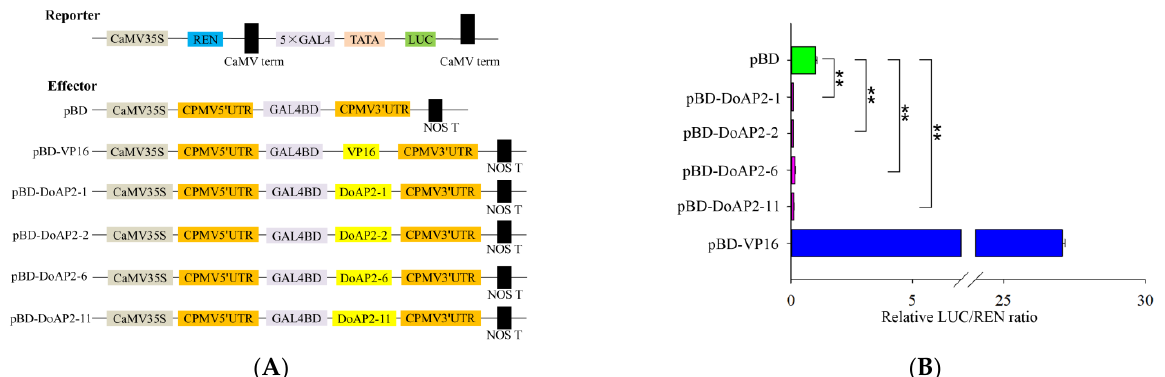
Figure 8. Transcriptional activity assay of DoAP2 genes in tobacco leaves. ( A ) Schematic presentation of the reporter and effector vectors; ( B ) Transcriptional repression ability of DoAP2 proteins in tobacco leaves. Double asterisks (**) indicate significant differences in two-treatment comparisons ( p < 0.01) using Dunnett’s test, compared with the negative control (pBD). Each value represents the means of six biological replicates.